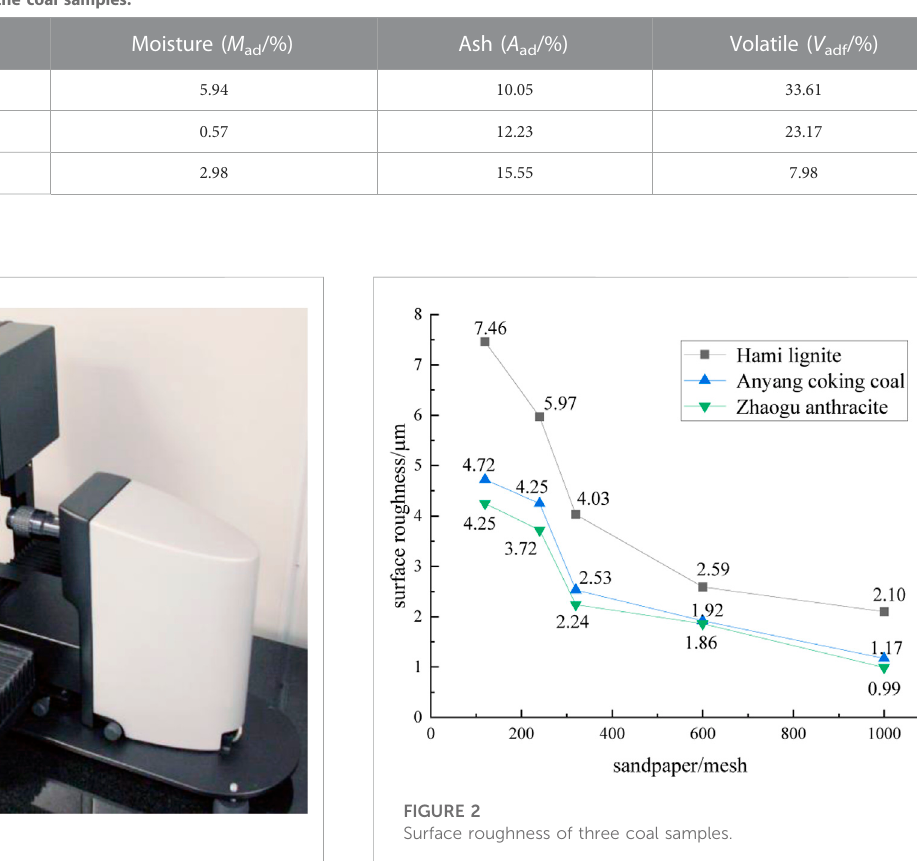
TABLE 1 Proximate analysis of the coal samples.